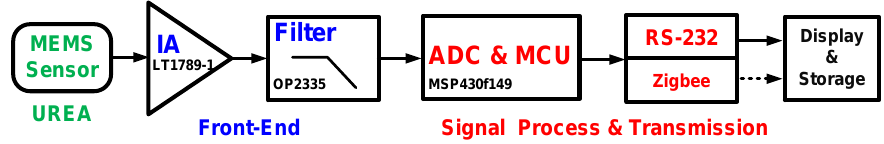
Figure 3. Block diagram of the proposed bio-electrochemical acquisition system.